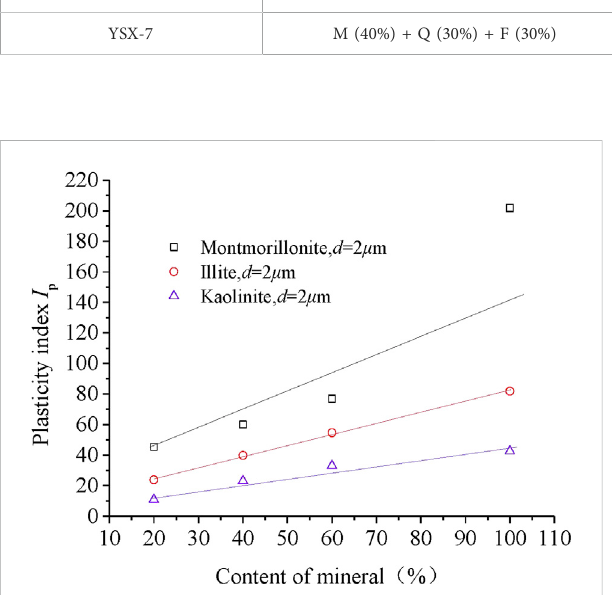
FIGURE 6 In fl uence of soil mineral content on sample plasticity index.